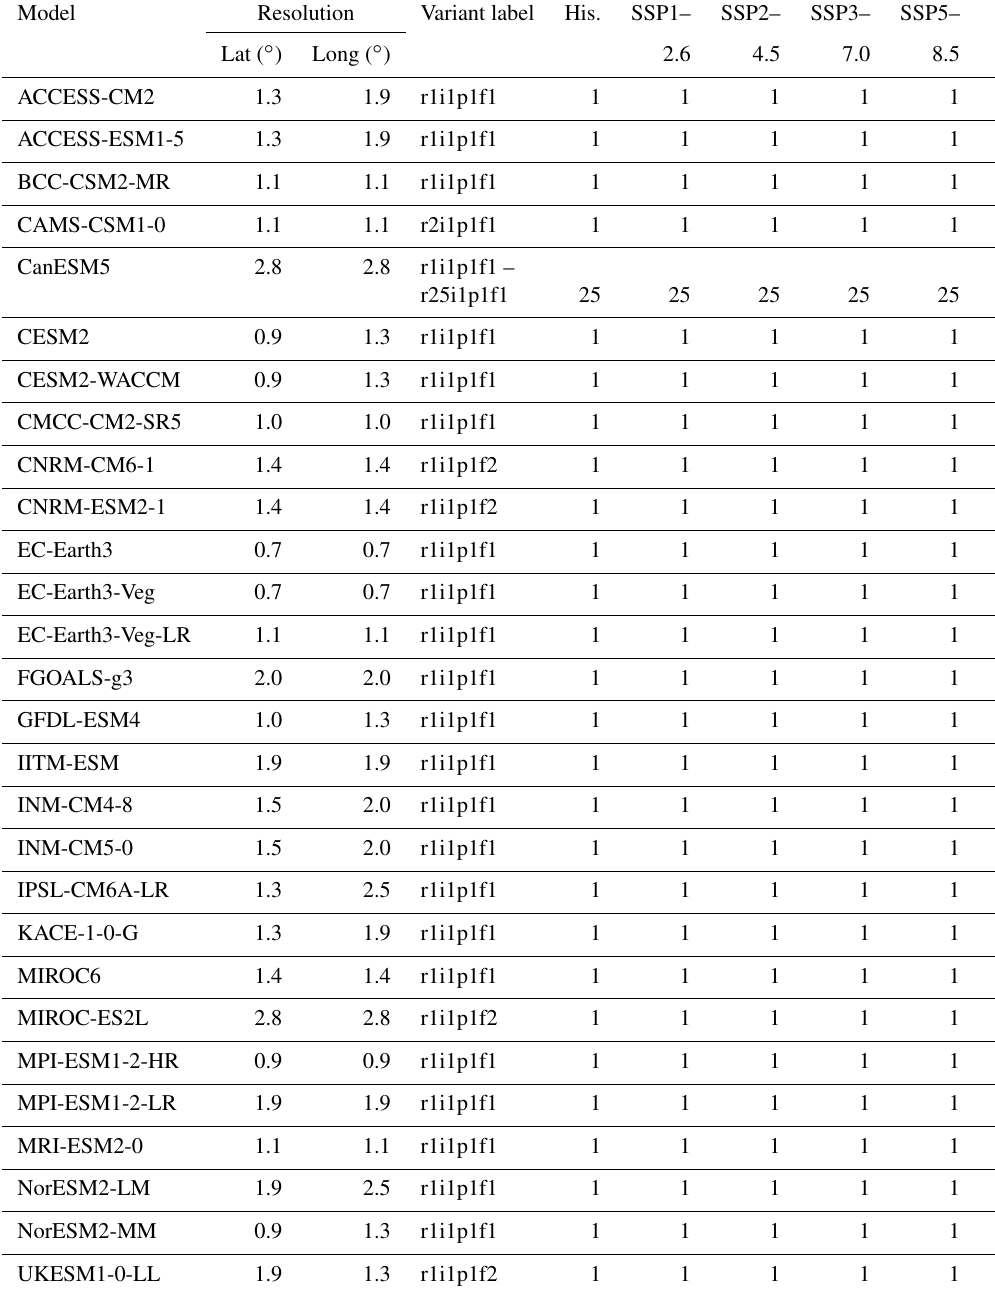
Table 1. Overview of the CMIP6 GCM ensemble used in this study (r – realisation or ensemble member; i – initialisation method; p – physics; f – forcing). The r1i1p1f1 run is used for all the GCMs except five GCMs for which this run is not available, and so their r1i1p1f2 and r2i1p1f1 runs are